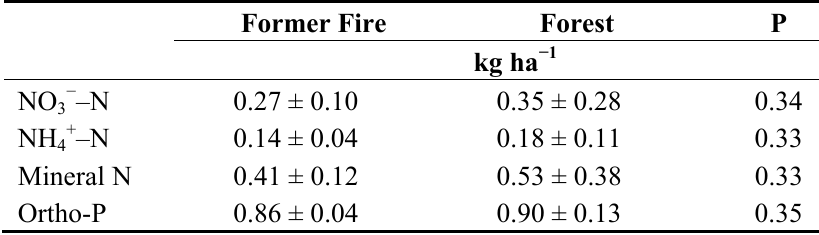
Table 5. Leaching fluxes during the 2006–2007 water years from resin lysimeters. Probabilities of differences between sites from Student’s t -tests were conducted on log transformed values are